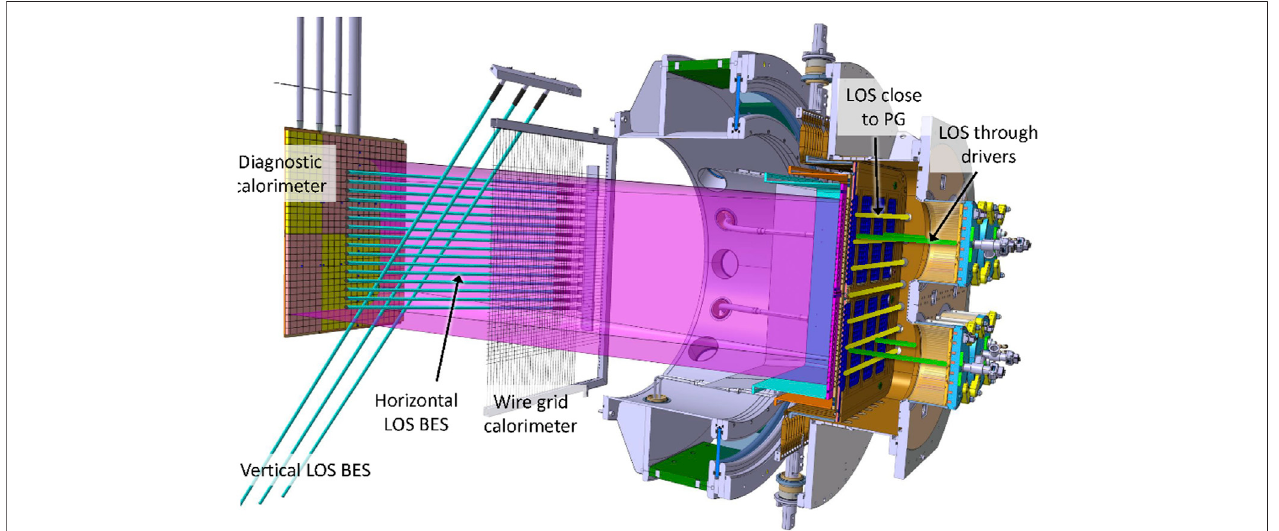
FIGURE 6 | Vertical cut through the ELISE ion source (right) together with the extraction system and beamline, including the wire grid calorimeter and the diagnostic calorimeter. Some lines of sight used close to the PG by OES, TDLAS and CRDS are shown in yellow. Shown in green are OES lines of sight observing the driver plasma. The 16 horizontal LOS and three of the four vertical LOS used by BES are shown in